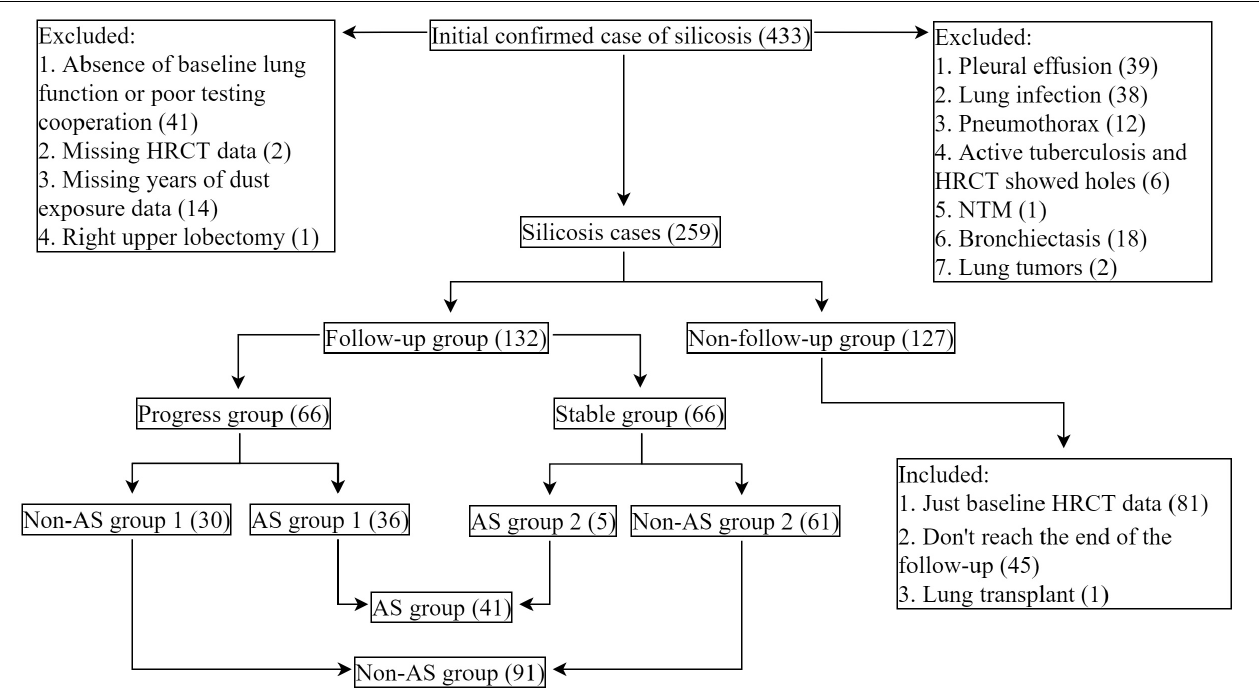
FIGURE 1 | Study flowchart. Cases of silicosis in Shanghai Pulmonary Hospital, Shanghai, China (2011.04–2021.04). AS-associated silicosis group is referred to as AS group; non-AS-associated silicosis group is referred to as non-AS